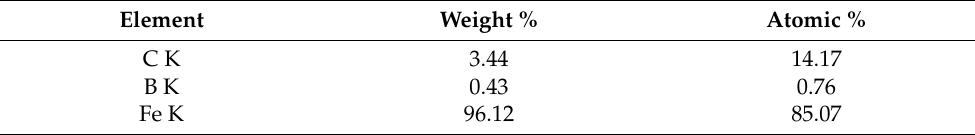
Table 11. EDX analysis quantitative at point A in specimen welded in inert conditions.